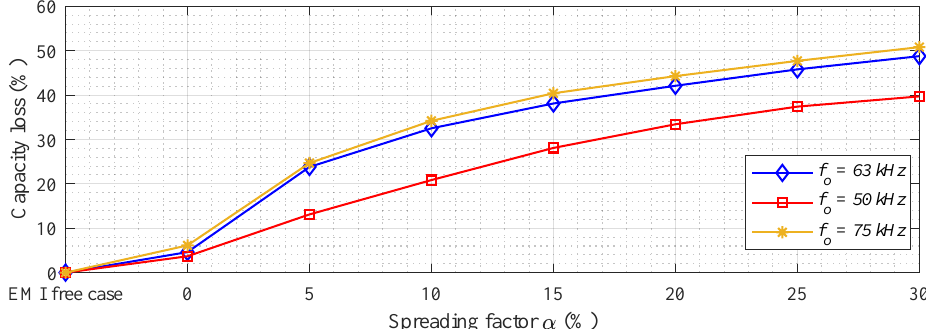
Figure 13. The PLC channel capacity loss in the case of several values of spreading factor with the change in the central switching frequency of